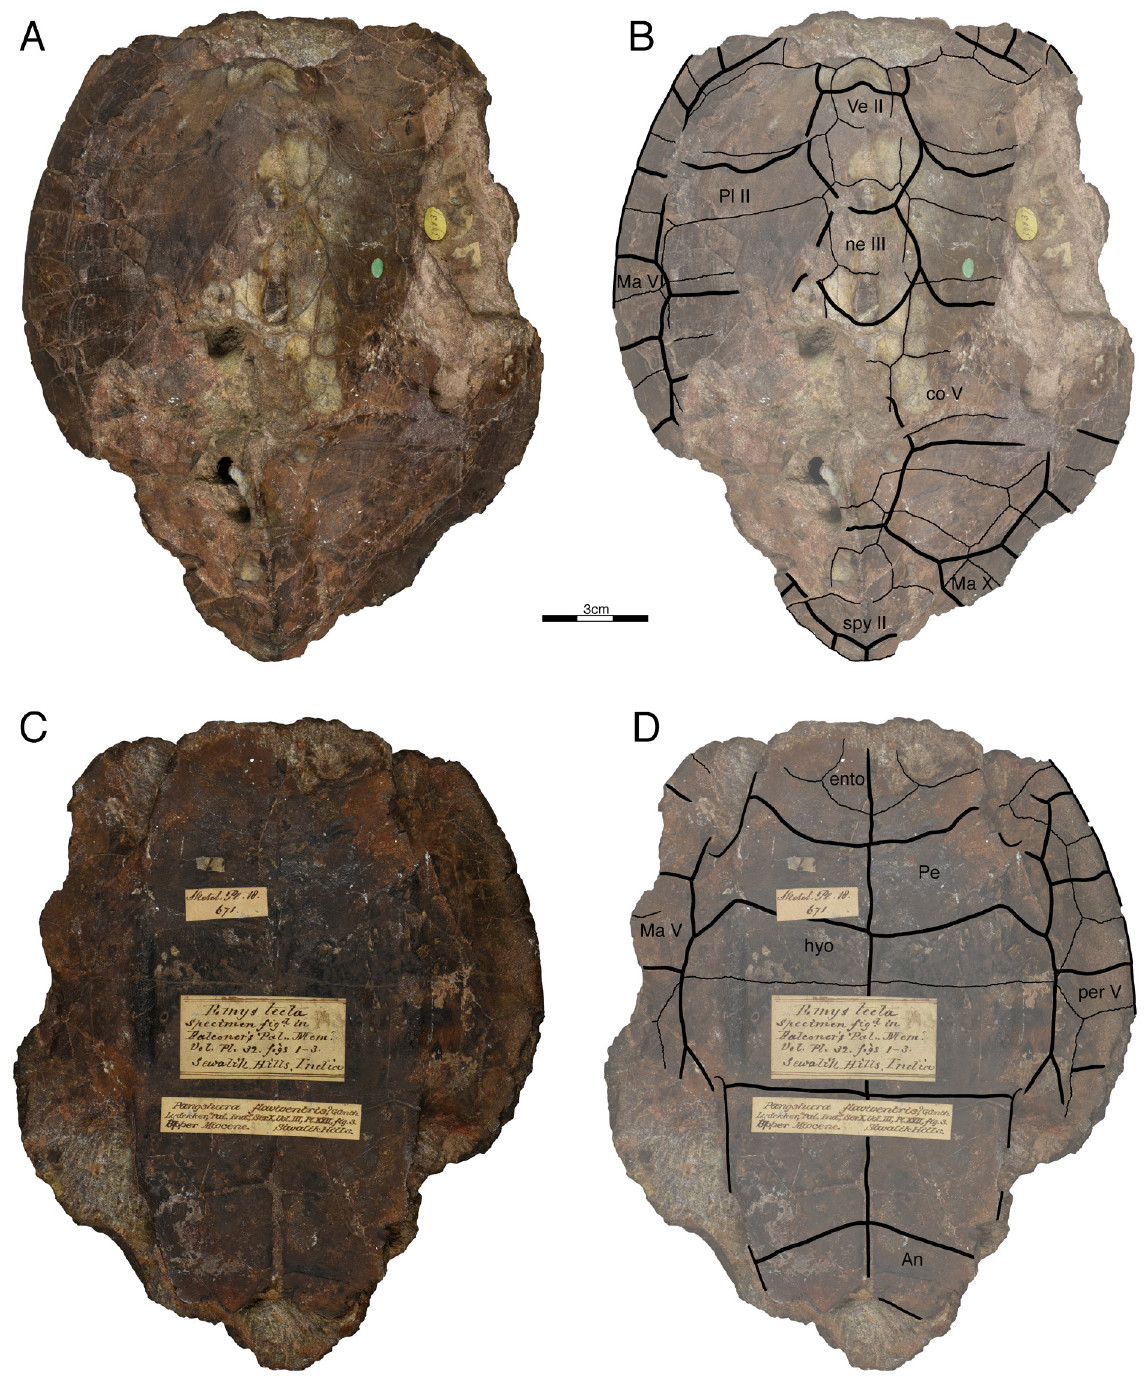
Fig. 16. BMNH 39837, referred to Pangshura flaviventer Günther, 1864 by Lydekker (1885a), here identified as Pangshura sp. A . Photograph of carapace. B . Illustration of carapace. C . Photograph of plastron. D . Illustration of plastron. Scale bar: 3